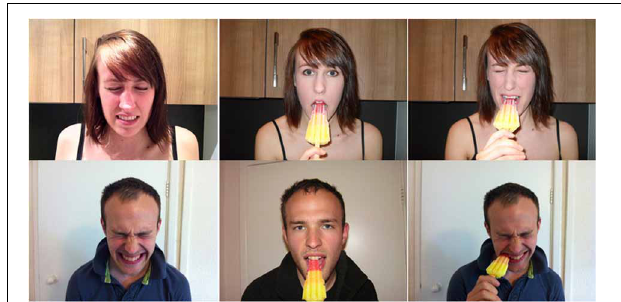
FIGURE 1 | The figure shows two dots and an avatar observing two dots (top), consistent with the participant’s viewpoint or observing one dot (bottom), inconsistent with the participant’s